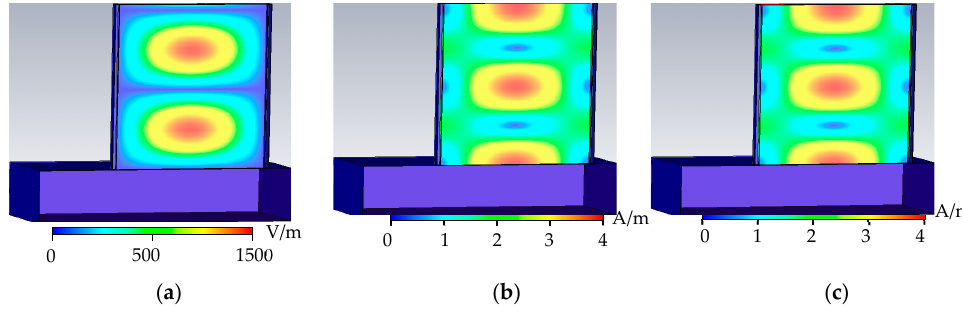
Figure 3. No ‐ defect field distribution. ( a ) No defect electric field distribution. ( b ) No defect magnetic field distribution. ( c ) No defect wall current distribution.